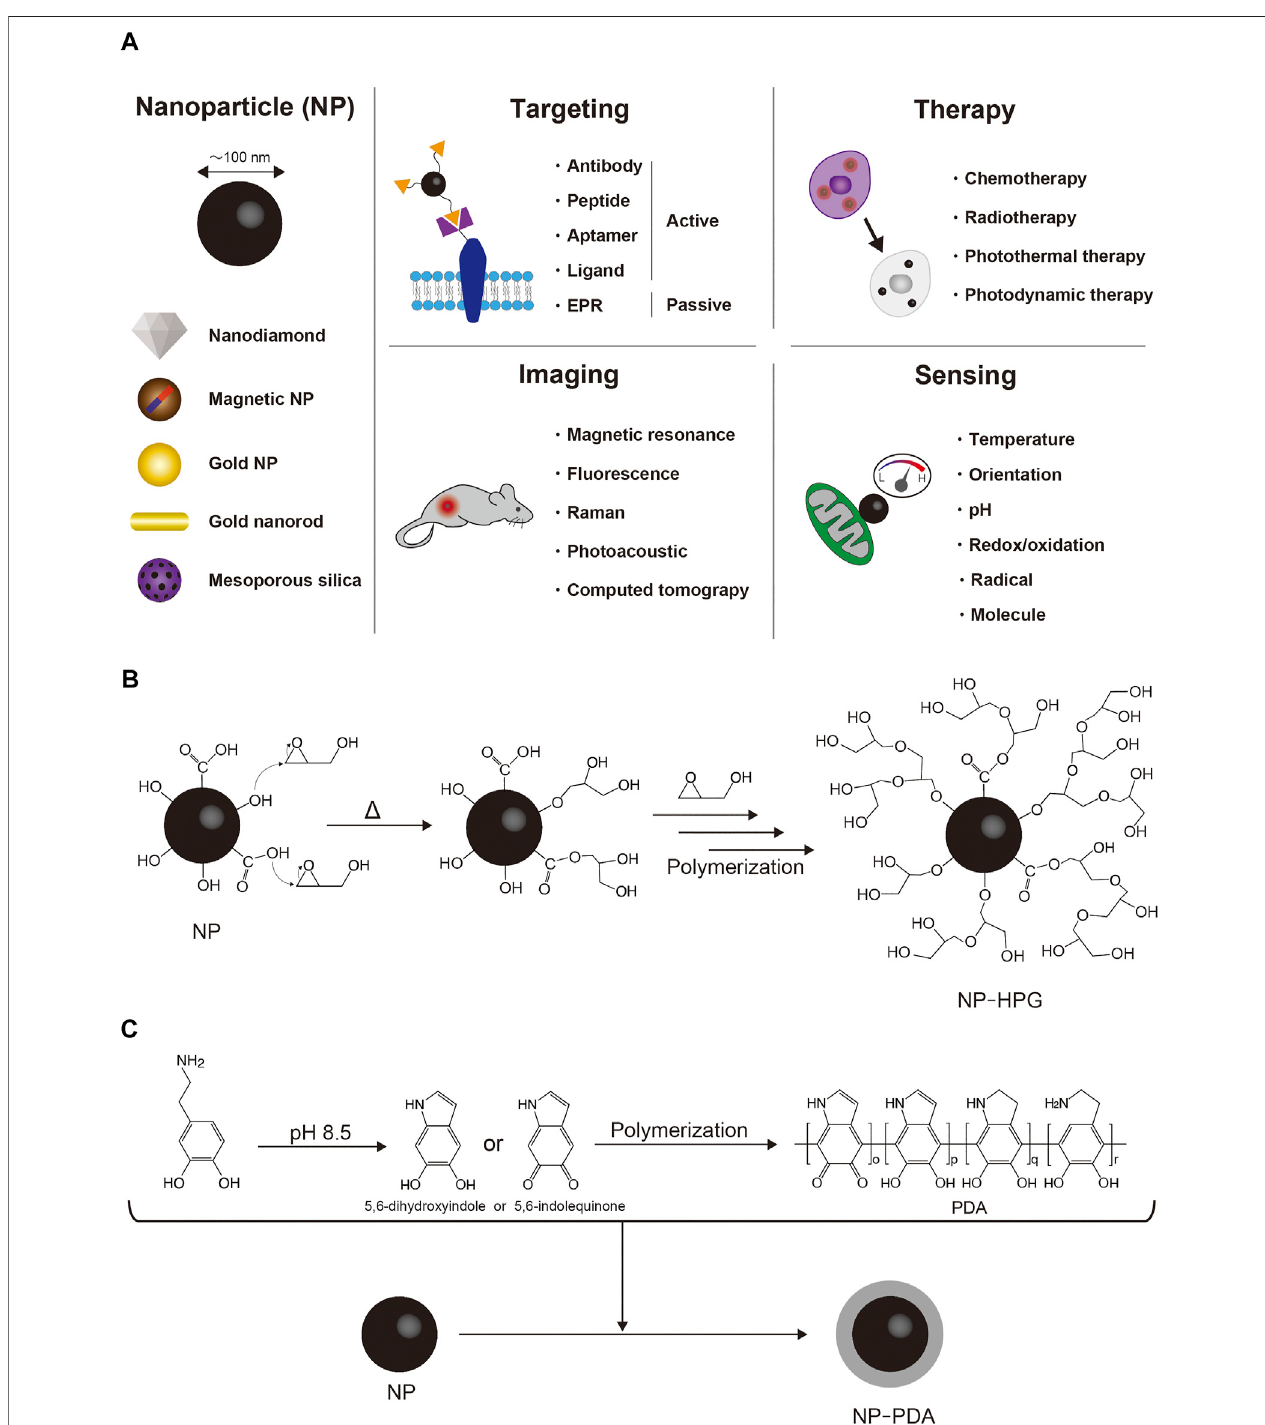
FIGURE 1 | Schematic illustration of (A) nanoparticles focused in this review and their biomedical application and synthesis of (B) NP-HPG and (C) NP-PDA.